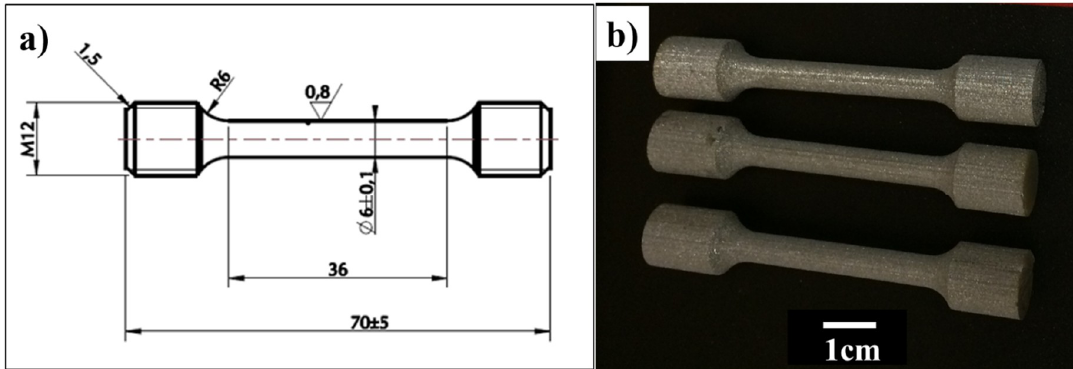
Figure 2. ( a ) ASTM E-8 tensile test geometry with d = 6 mm end sections for M12 threads machining, and ( b ) images of Ti-6Al-4V tensile test specimens manufactured via selective laser melting (SLM). Only the threads section was machined to examine the influence of post-processing on the gauge